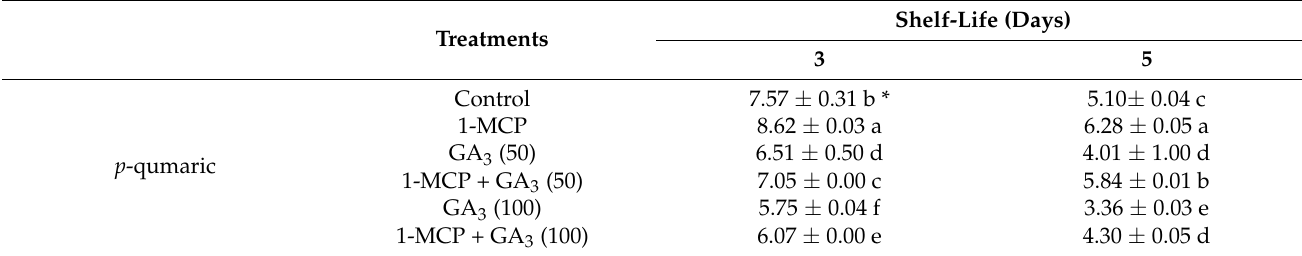
Table 5. Effect of 1-MCP and GA 3 treatments on the p -qumaric acid, ferulic, phloridzin, and quercetin acid contents during shelf-life of strawberry fruits (mg 100 g − 1